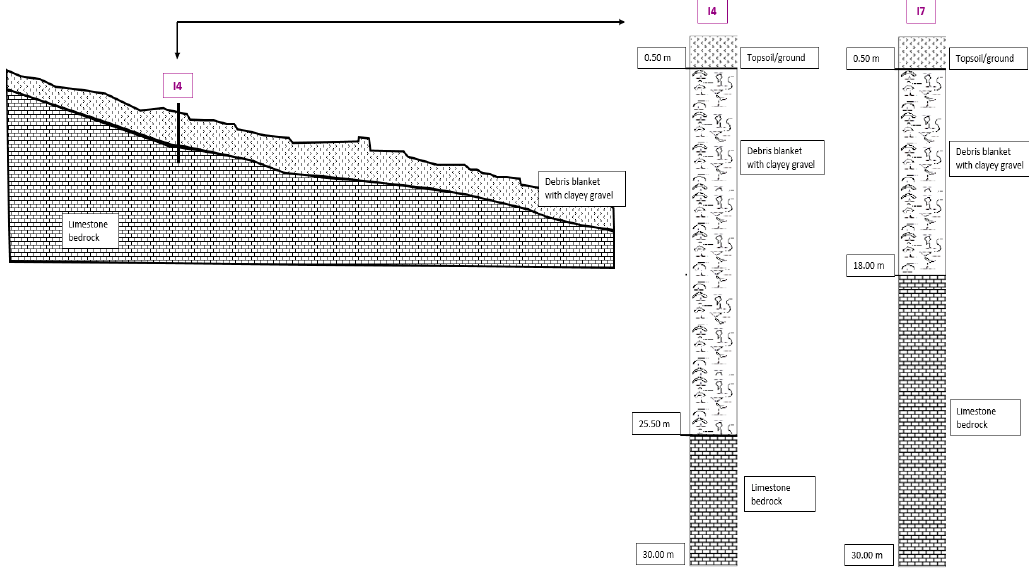
Figure 3. Geotechnical and geophysical surveys in Ville San Pietro.